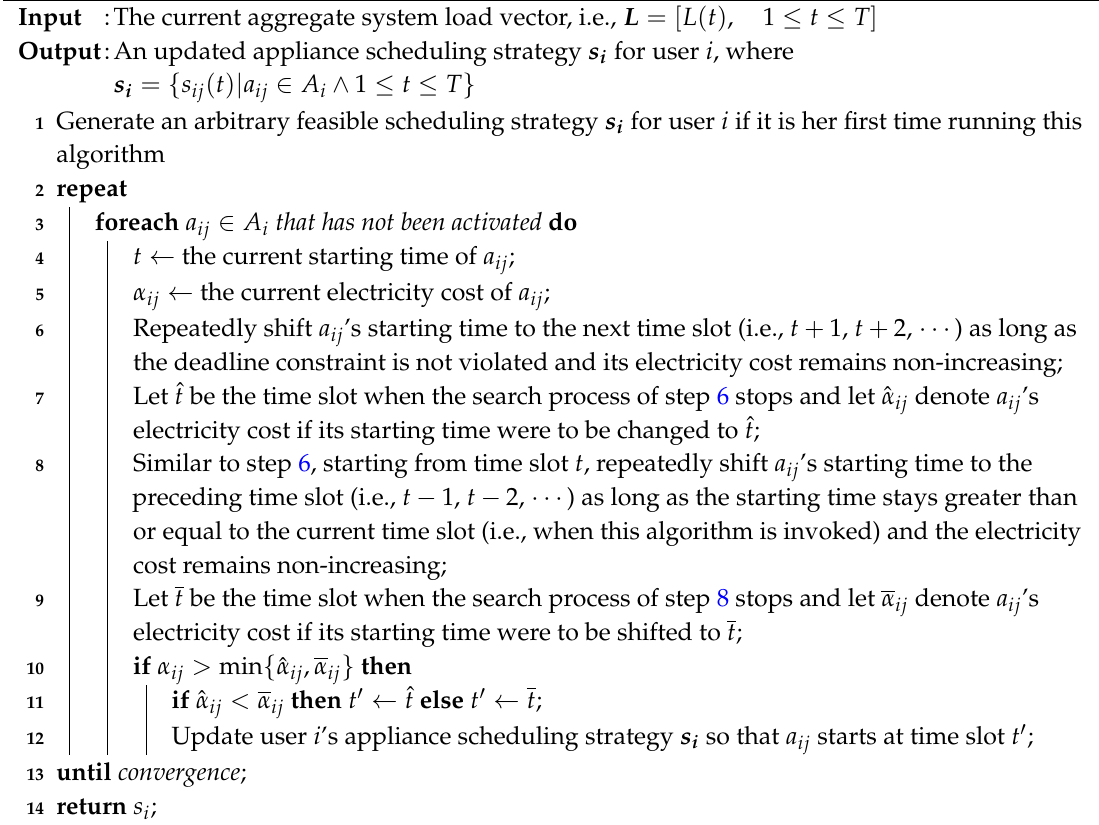
Algorithm 1: Appliance scheduling algorithm (executed by each individual user i